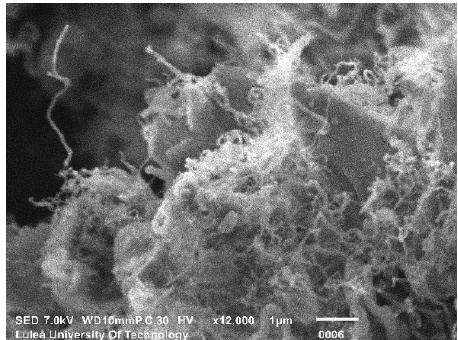
Figure 5. SEM image of SmartCem I.